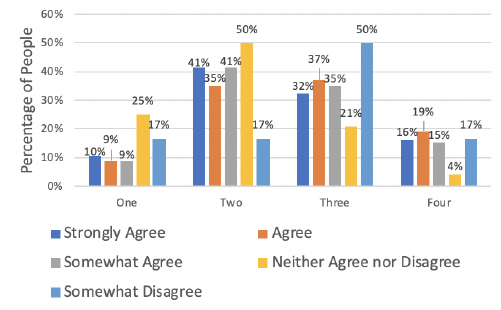
Figure 7. Responses to question about the use of strong passwords and password scores.